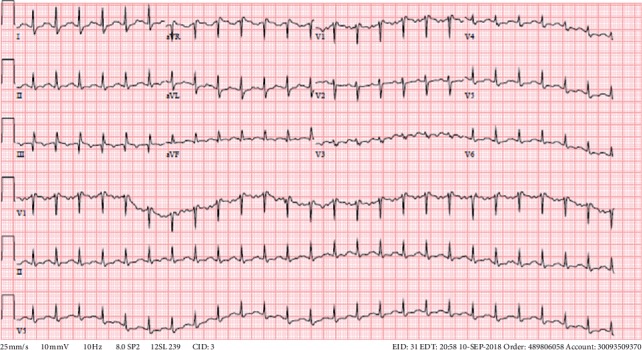
Electrocardiogram.